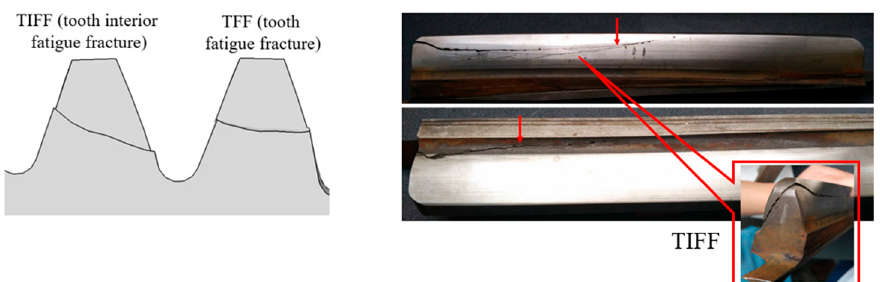
Figure 2. Crack source of failed gears. Figure 1. Crack source of failed gears.